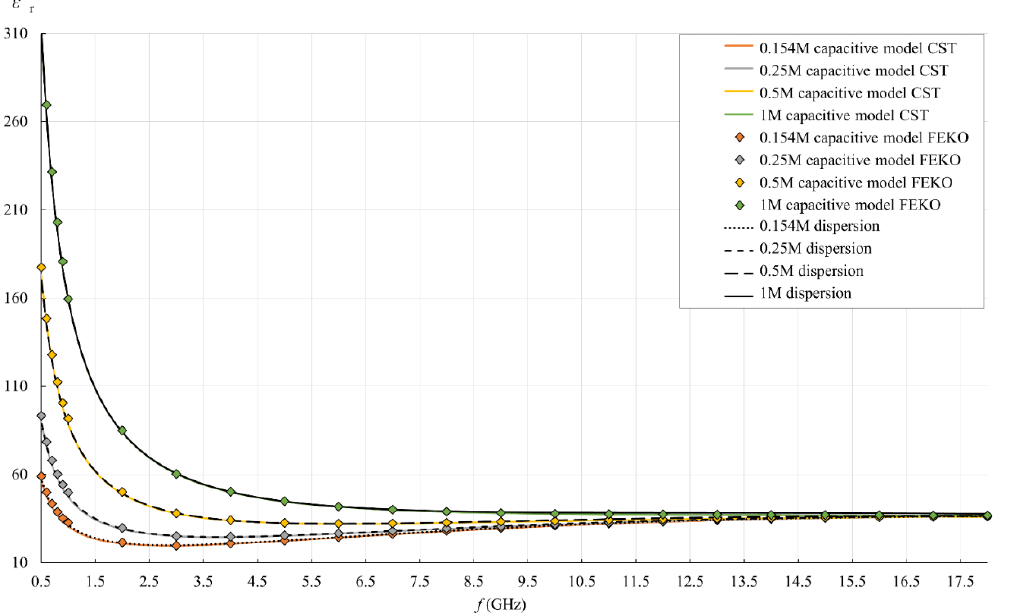
Figure 13. 𝜀 r′ for all saline solutions: simulation results obtained by postprocessing the reflection coefficient using the simple capacitive- load model (“capacitive model”), where the reflection coef- ficient was obtained by simulations either in CST (colored lines) or in FEKO (discrete points); Cole – Cole dispersion model (“dispersion”), which was the set 𝜀 r′ value for MUT in simulations (black lines).